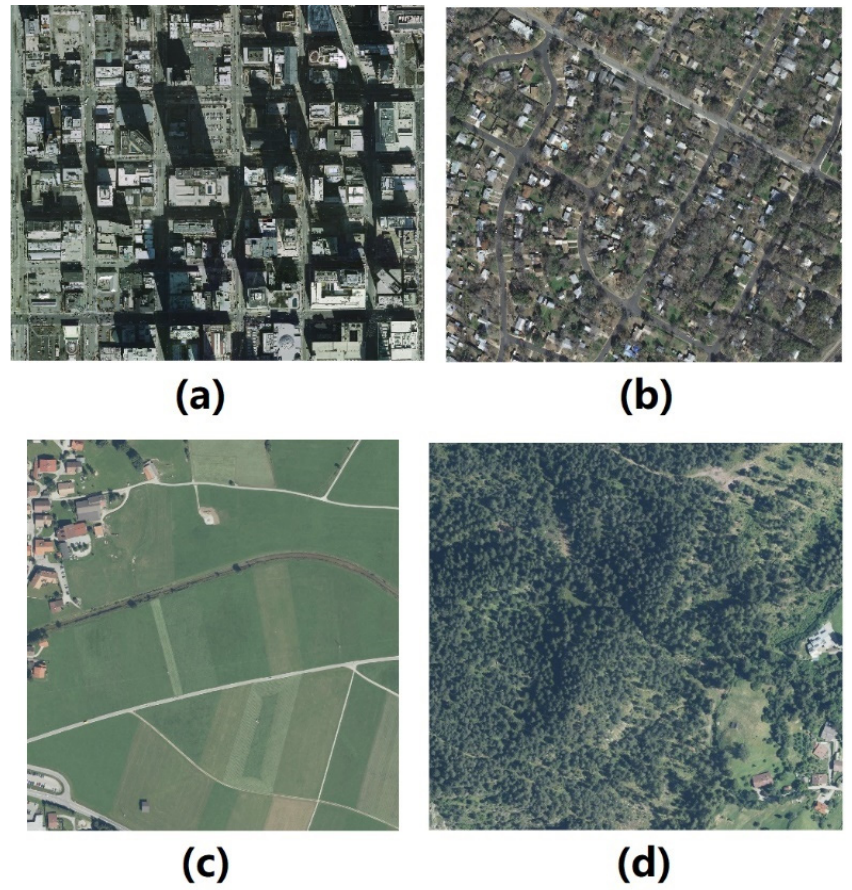
Figure 1. Typical images selected from the INRIA Aerial Image Labeling dataset to create the dehazing dataset: ( a ) city, ( b ) residential, ( c ) farmland, and ( d ) forest areas. The size of each image was 5000 × 5000, and the images were divided into many 70 × 70 images. Then, for each 70 × 70 image block, we randomly selected transmissions in the range (0.2, 0.9) to generate the hazy images. Thus, 40,328 hazy images and the corresponding clear images were created. For validation, 4032 of the images were selected, and the remainder were used for training. For testing, eight group images which were independent of the above 40,328 images were used. There were 250 images in each group. These eight group images also represented the four typical scenes, with two groups for each